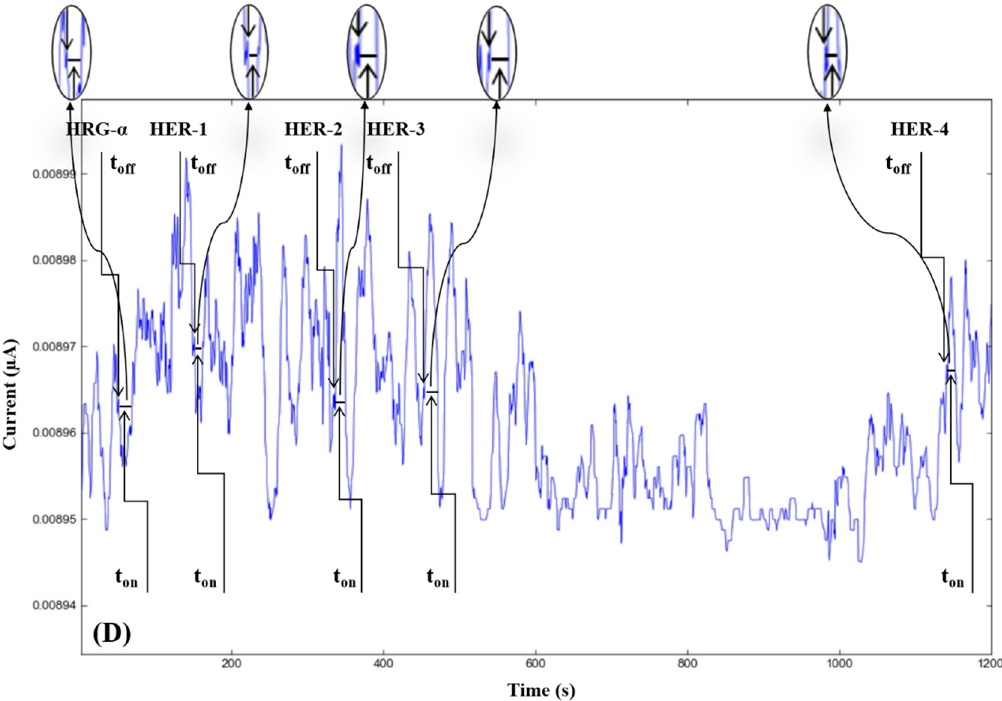
Figure 3. Stochastic diagrams recorded in whole blood samples with 3D stochastic microsensors based on IN/AuNP-MWCNT ( A ), IQ/AuNP-MWCNT ( B ), HD/AuNP-MWCNT ( C ), and TEX/AuNP-MWCNT ( D ).